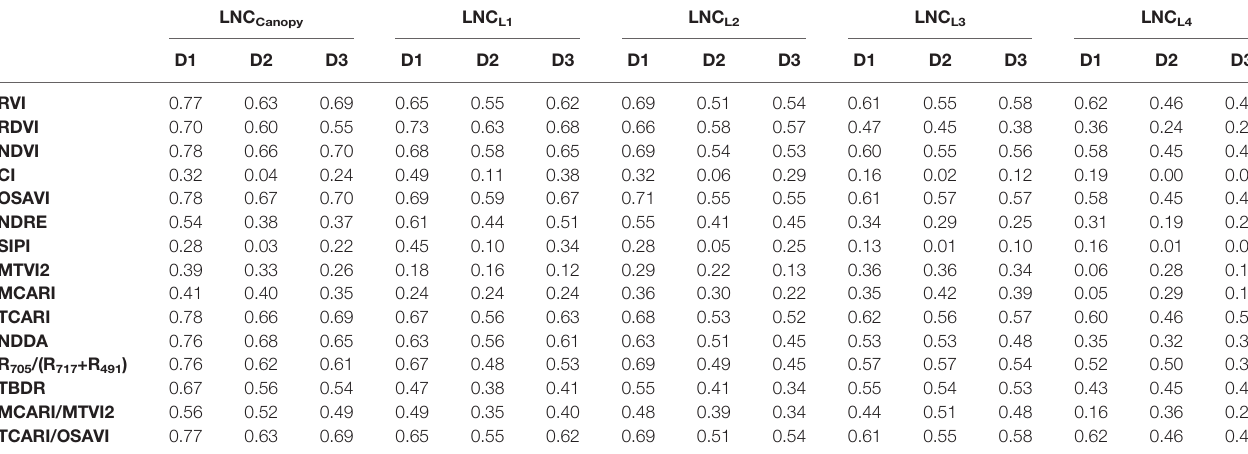
TABLE 4 | Coef fi cients of determination (R 2 ) for the relationship between the vegetation indices and the leaf nitrogen concentration in different planting densities. LNC